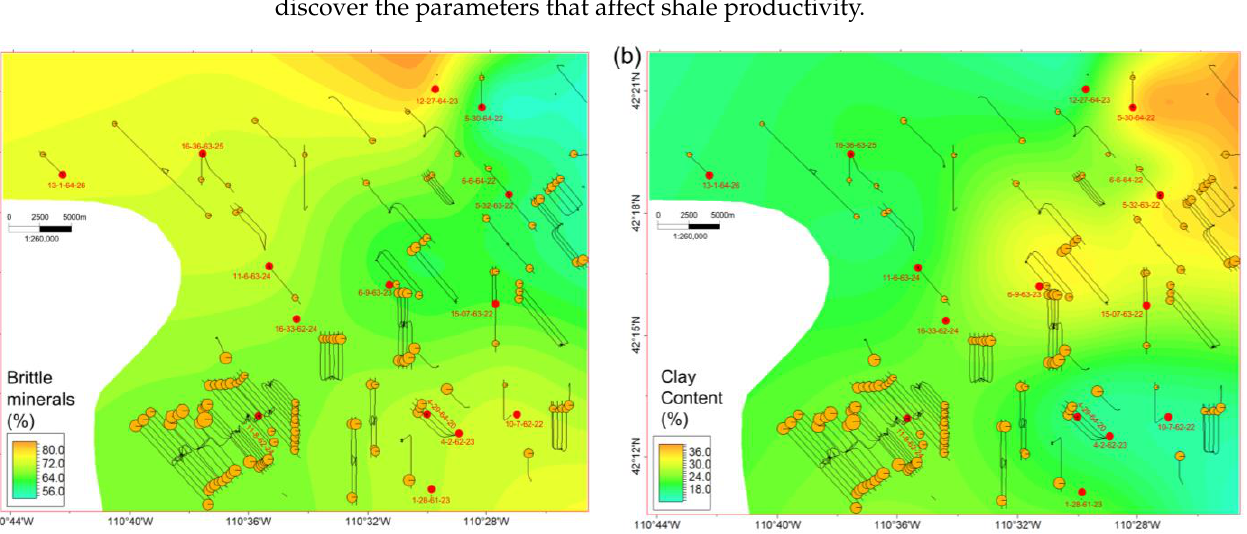
Figure 5. Mineralogy measurements for coring wells. Clay, quartz, feldspar, and calcite are primary minerals.